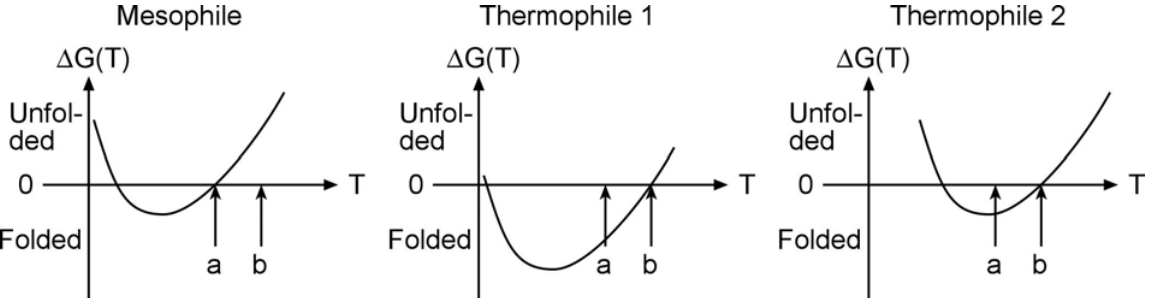
Figure 2. Thermophiles: stable everywhere or at high T